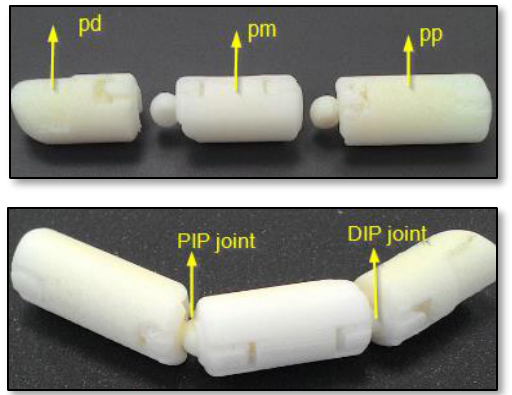
Figure 6. The 3D printed finger Phalanges and Joint